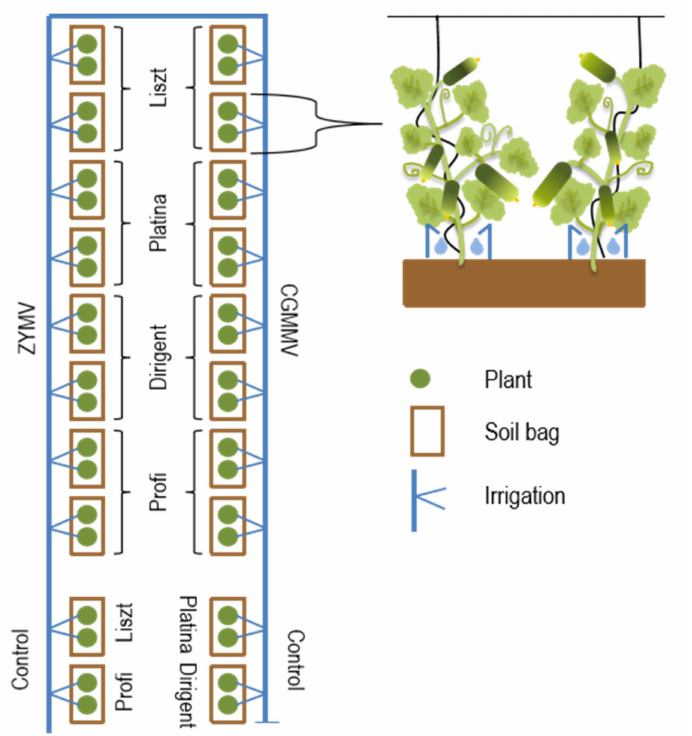
Figure 1. Cultivation design for Cucumis sativus plants infected with Zucchini yellow mosaic virus (ZYMV) or Cucumber green mottle mosaic virus (CGMMV) and control. Plants were cultivated under greenhouse conditions in soil bags; water was supplied via drip irrigation. Two plants of each cultivar (‘Platina’, ‘Liszt’, ‘Dirigent’ and ‘Profi’) served as controls. Four plants per cultivar were infected with one of the